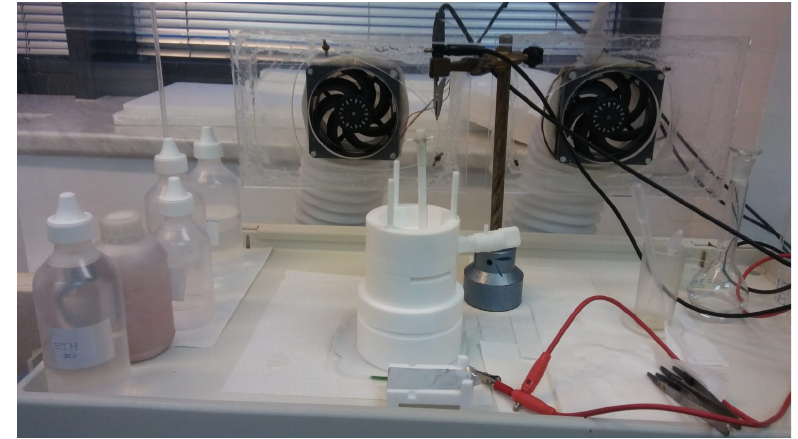
Figure 1. Polytetrafluoroethylene (PTFE) etching chamber. See Section 2.3 for